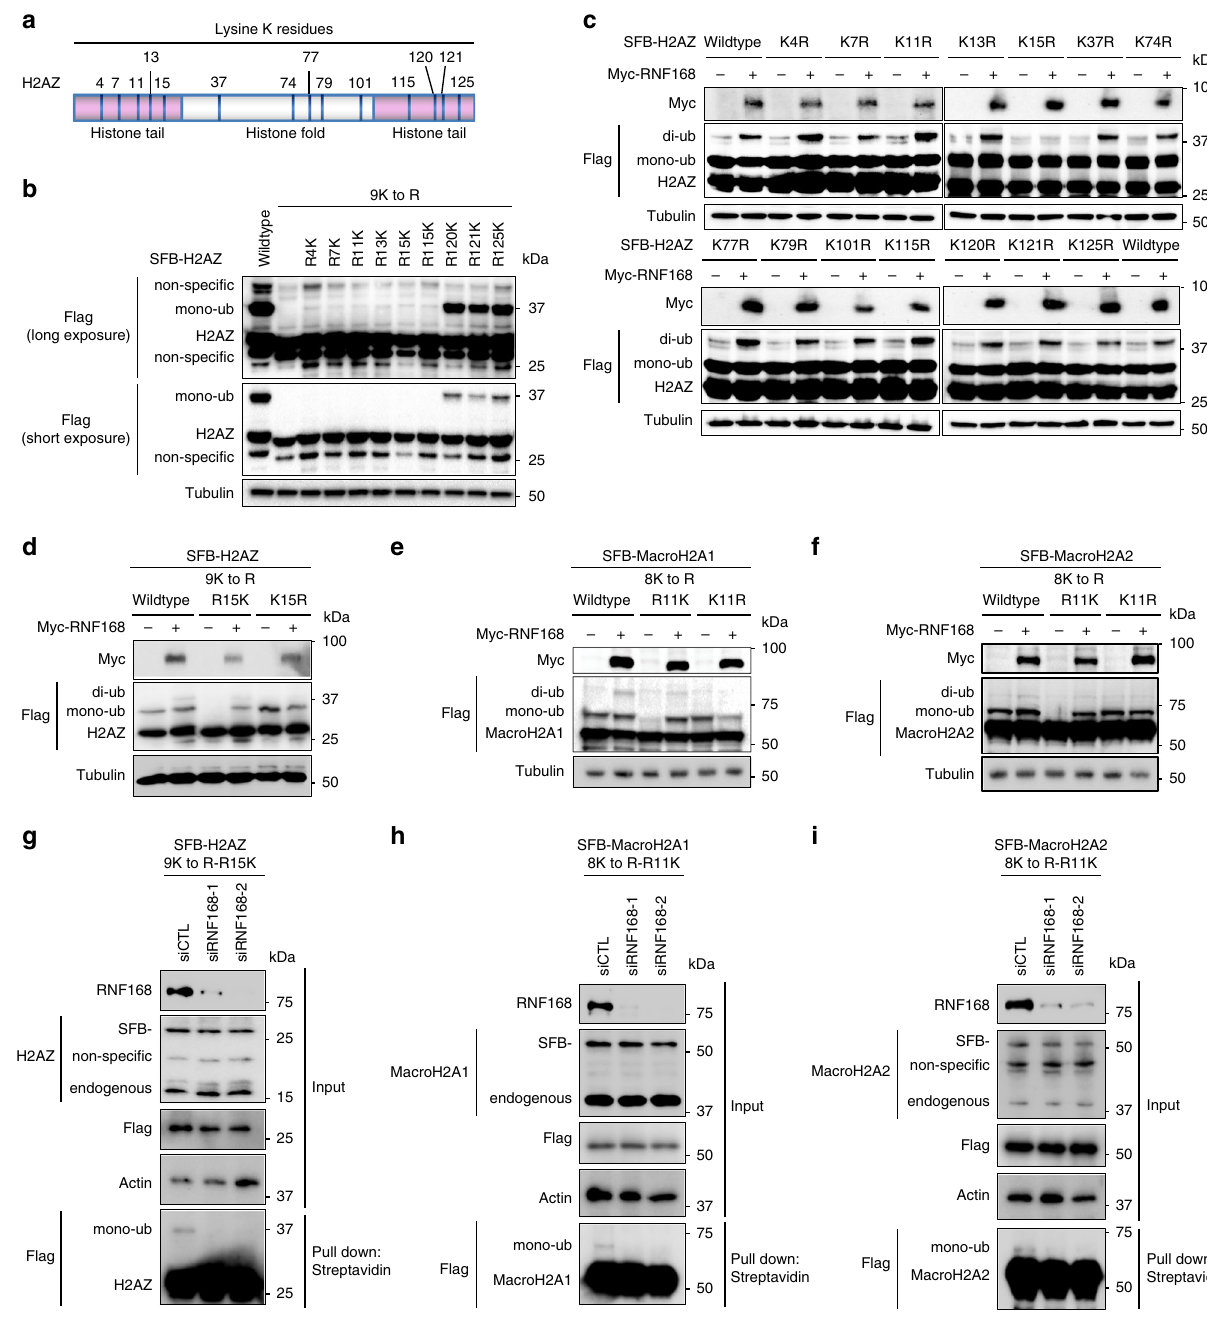
Fig. 2 RNF168 ubiquitinates H2A variants at a speci fi c lysine residue. a Schematic diagram of the lysine residue distribution of H2AZ. b H2AZ C- terminus is the major Ub-acceptor. SFB-H2AZ wildtype and mutants were transfected in HEK293T cells for 24 h, harvested with SDS-PAGE sample buffer, and followed by western blot analysis using Flag antibody and tubulin as loading control. Repeated two times independently with similar results. c RNF168 speci fi cally ubiquitinates H2AZ at K15. Co-transfection of Myc-RNF168 and SFB-H2AZ wildtype and mutants with lysine to arginine mutation in HEK293T cells as indicated. Repeated three times independently with similar results. d – f RNF168 ubiquitinates H2A variants at a speci fi c lysine residue. SFB-H2AZ, SFB-macroH2A1, and SFB-macroH2A2 wildtype and mutants were co-transfected with Myc-RNF168 in HEK293T cells followed by western blot analysis using antibodies as indicated. Repeated at least three times independently with similar results. g – i RNF168 is required for site-speci fi c ubiquitination of H2A variants. HEK293T cells with stable expression of CMV-SFB-H2AZ 9K to R-R15K, CMV-SFB-MacroH2A1 8K to R-R11K, EF1 α -SFB- MacroH2A2 8K to R-R11K were transfected with siRNAs targeting RNF168. Cells were harvested and pulled down using streptavidin agarose. Pull-down samples were analyzed by western blot with indicated antibodies. Repeated four times for g-h and two times for i with similar results. Source data are provided as Source Data fi